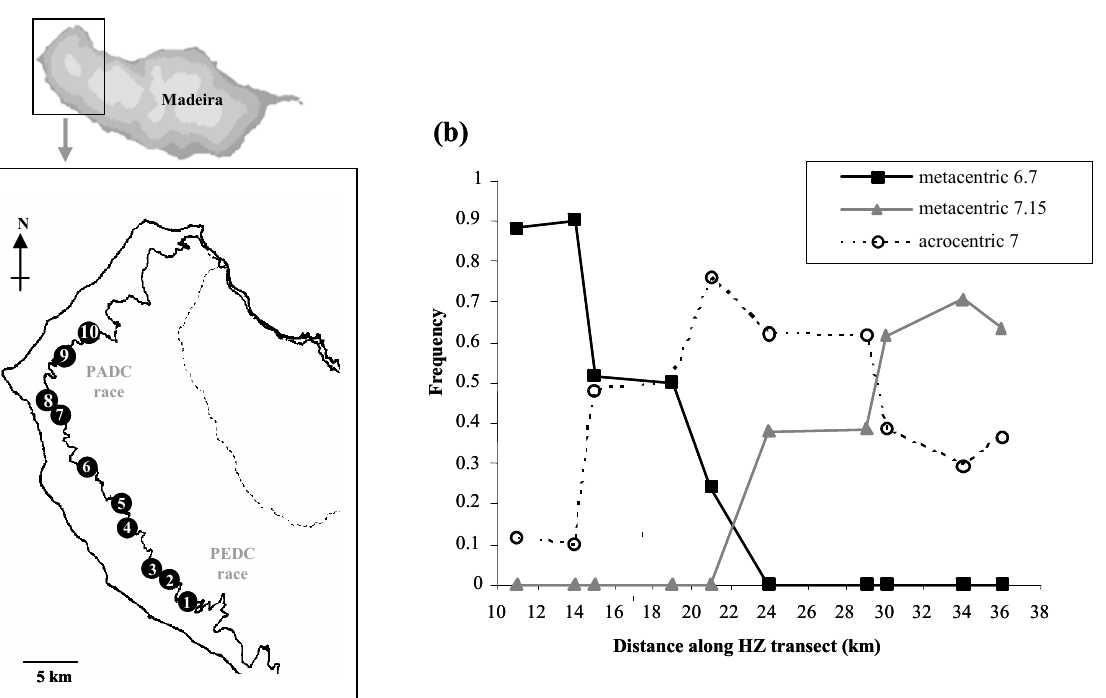
Figure 6. The Madeira house mouse hybrid zone between the PEDC and PADC chromosomal races, based on data in Nunes et al . [34]. (a) Map showing the ten collection sites that form a transect between the two races. (b) Frequencies of the three ‘alleles’ of chromosome 7 along the